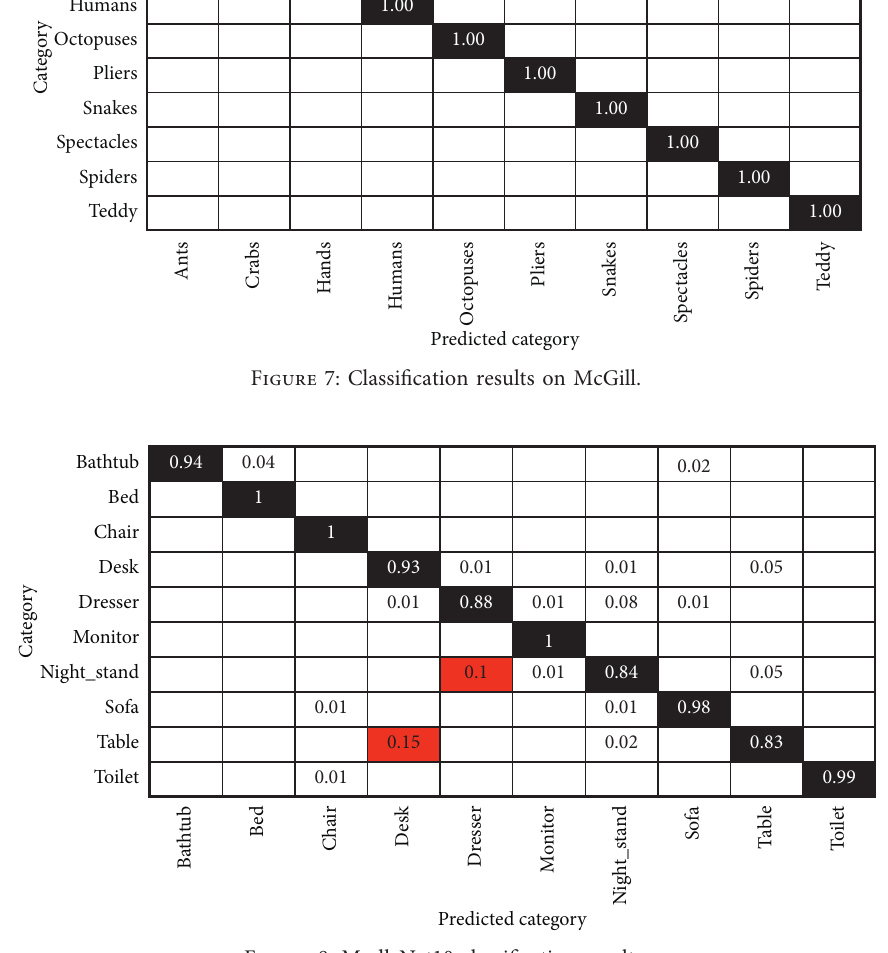
Figure 8: ModleNet10 classification results.